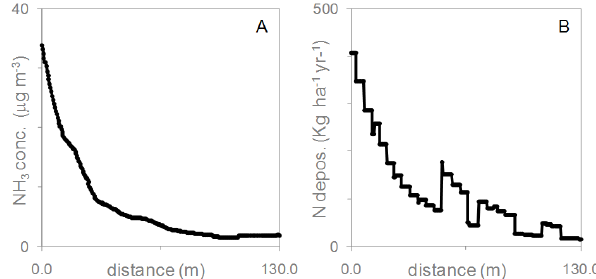
Fig. 2. Atmospheric ammonia concentration (A) and N deposition (B) along a transect from the N source (the cow barn, at distance 0) and up to 130m distance, in the prevailing wind direction, SE. Atmospheric ammonia concentrations were calculated from a geo- statistical model of measured ammonia concentrations for one year period, N deposition was calculated from LADD model. The ele- vated steps in the N deposition data are due to the differences be- tween the deposition rates to trees and